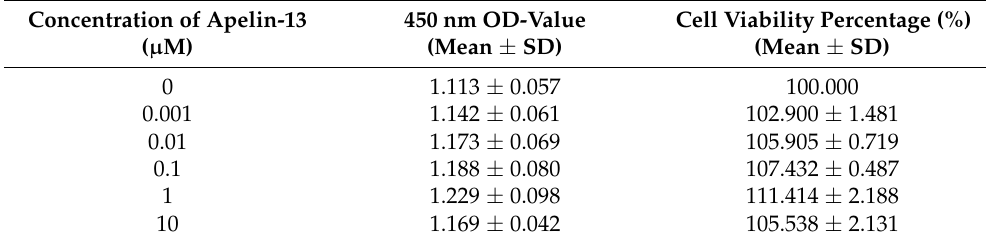
Table 1. Cytotoxicity of Apelin-13 at different concentrations was determined by CCK-8 assay. Concentration of Apelin-13